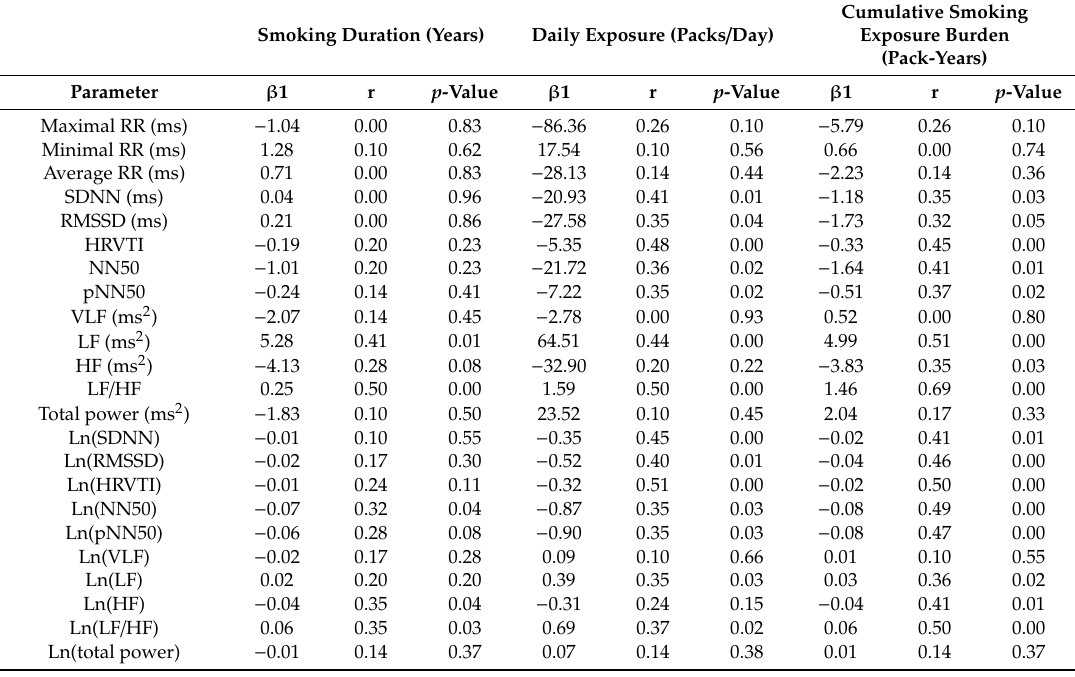
Table 4. Regression analysis between smoking burden and HRV parameters. Smoking Duration (Years) Daily Exposure (Packs /